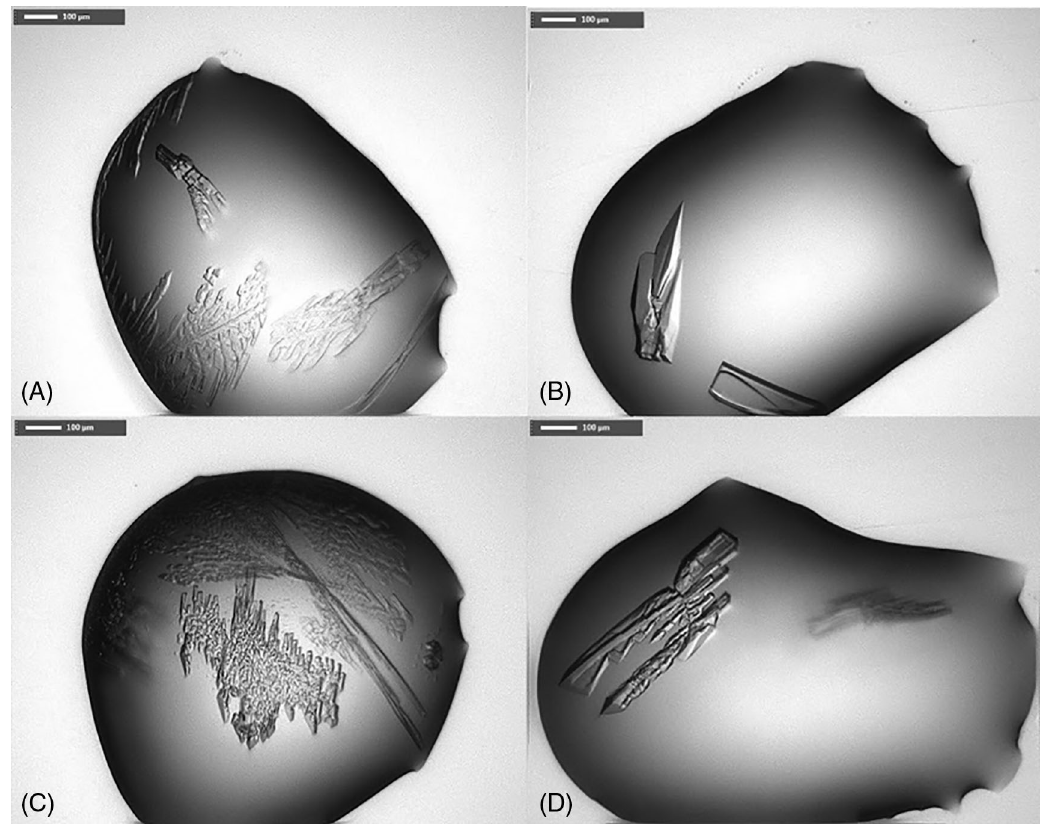
Figure 4. Selected Pa FabB C161A crystals obtained from various screens. A) condition F3 from LFS, B) G3 from LFS, C) F3 from PACT premier, D) G3 from PACT premier (for composition of crystallization buffer see Table 1).